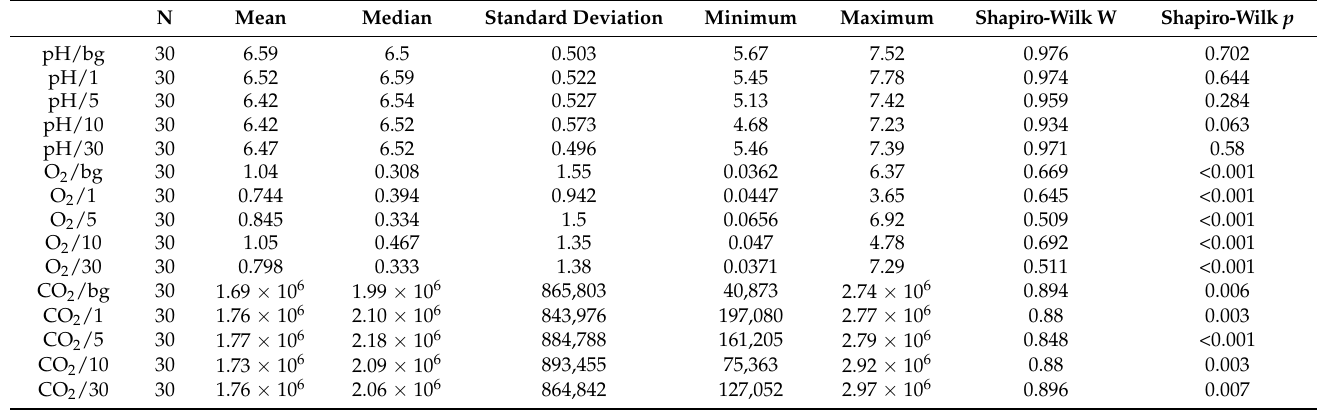
Table 3. Descriptive data (mean, SD, distribution) of pH, O 2, and CO 2 measurements for the entire sample.